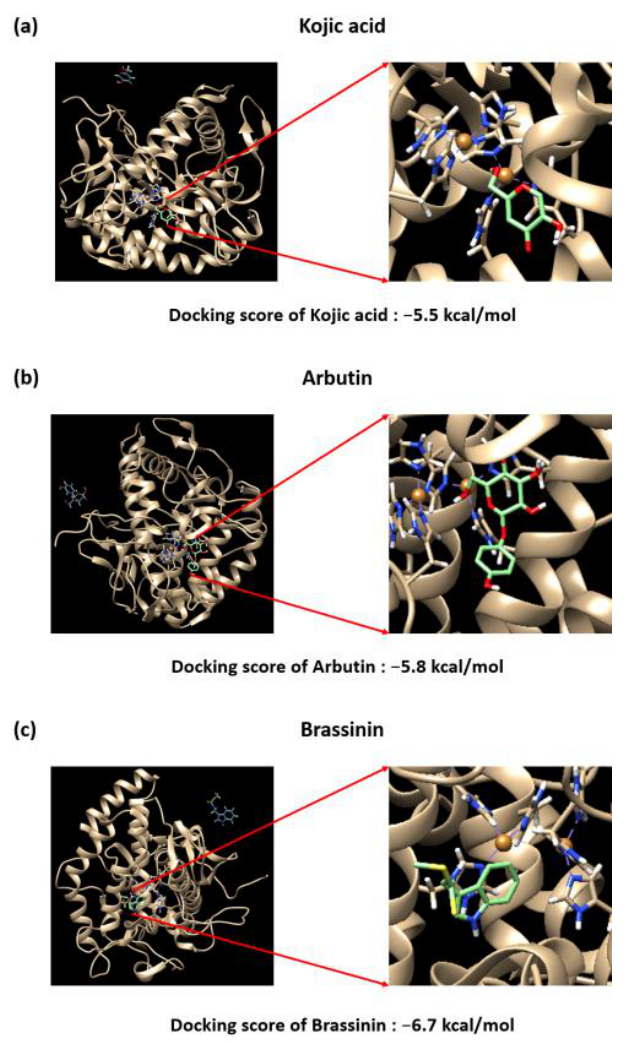
Figure 5. Binding affinity between Agaricus bisporus (PDB ID: 2Y9X) and ( a ) kojic acid (CID: 3840), ( b ) arbutin (CID: 440936), or ( c ) brassinin (CID: 3035211). AutoDock Vina software was used to predict the ligand binding capacity of brassinin, which exhibits strong inhibitory activity against